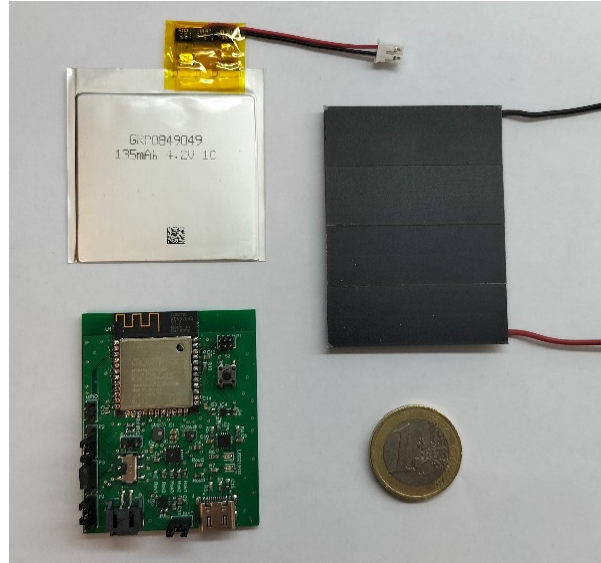
Figure 7. Parts of the designed device. Flexible battery (upper left), PCB (lower left) and solar cells module (right). 1 EUR coin used as a size reference.